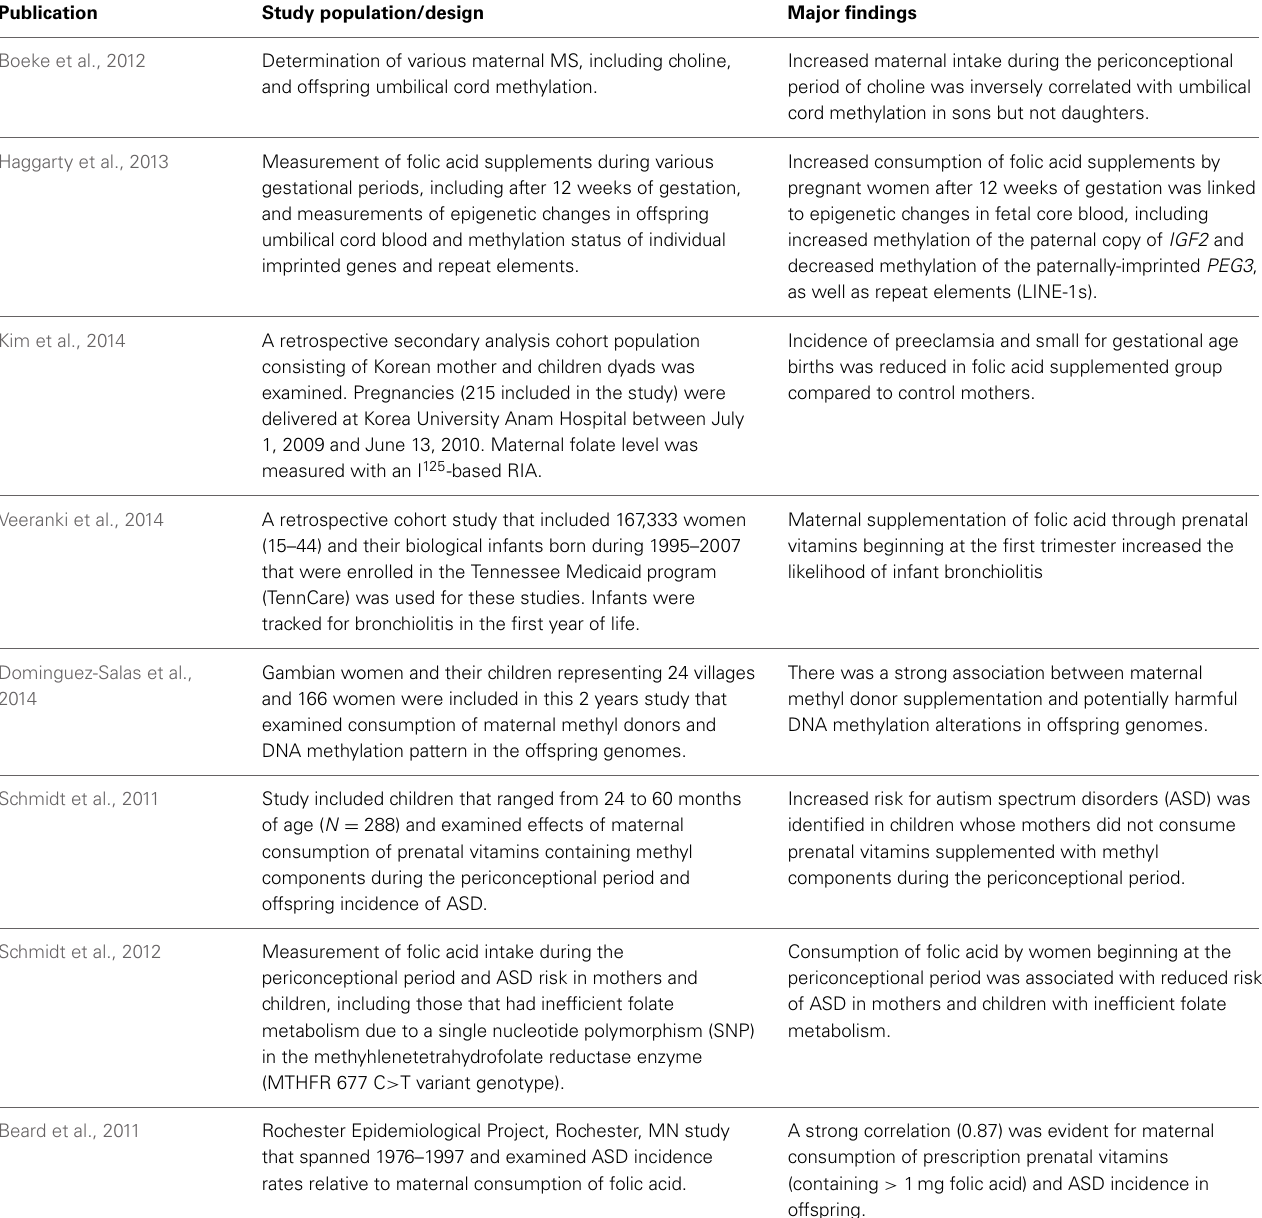
Table 1B | Human epidemiological studies linking maternal MS diets and effects on offspring health and